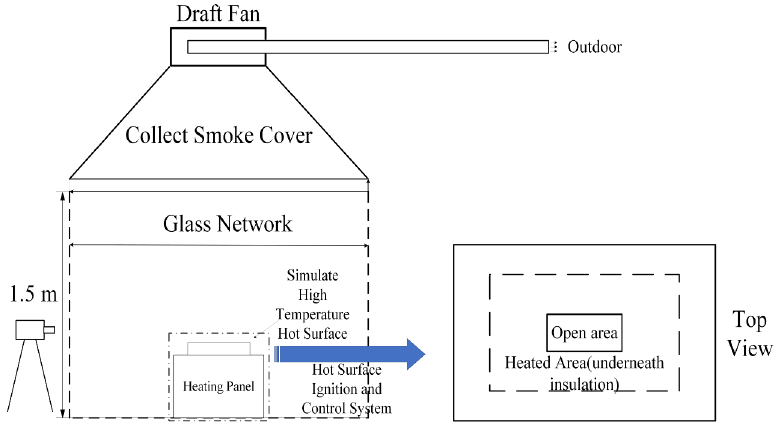
Fig. 1. Experimental setup for the hot wall ignition of leaking